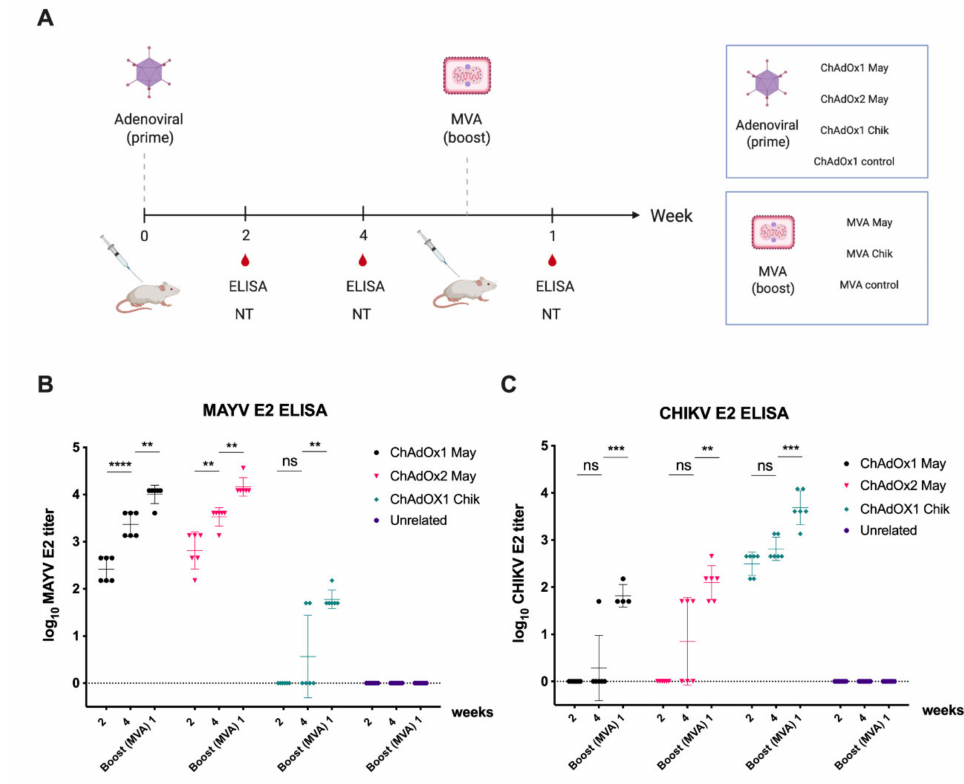
Figure 4. Description of vaccination regimen and humoral responses elicited by adenoviral-MVA based MAYV and CHIKV vaccines. ( A ) A group of BALB/c mice ( n = 6) were immunised with one of adenoviral vaccines (May or Chik) or unrelated ChAdOx1 DENV NS1 vaccine. All mice were boosted with MVA encoding the same antigens. Serum samples were collected at 2 or 4 weeks after prime immunisations and 1 weeks after P-B immunisations for immunogenicity (ELISA) and neutralisation assays (NT). ( B , C ) Humoral IgG responses elicited by the vaccines were quantified by ELISA in plates coated with MAYV E2 or CHIKV E2. Coloured lines represent the mean with SD ( n = 6 per group) and error bars. p values were determined by one-way ANOVA and Tukey’s multiple comparisons test. p > 0.05 (ns), p < 0.01 (**), p < 0.001 (***), and p < 0.0001